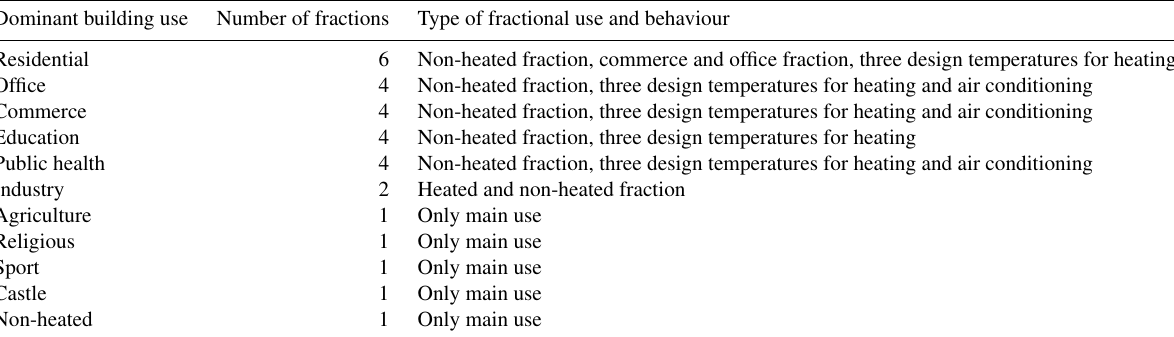
Table 1. Overview on the detail of representation of fractional building use and human behaviour for simulations in France. Dominant building use Number of fractions Type of fractional use and behaviour Residential 6 Non-heated fraction, commerce and office fraction, three design temperatures for heating 4 4